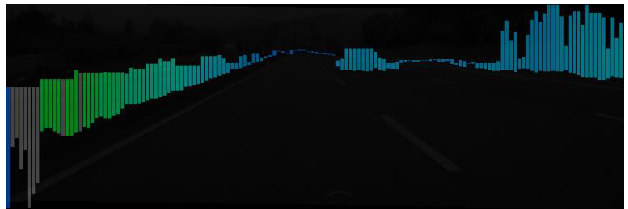
Figure 7. Result of height segmentation.